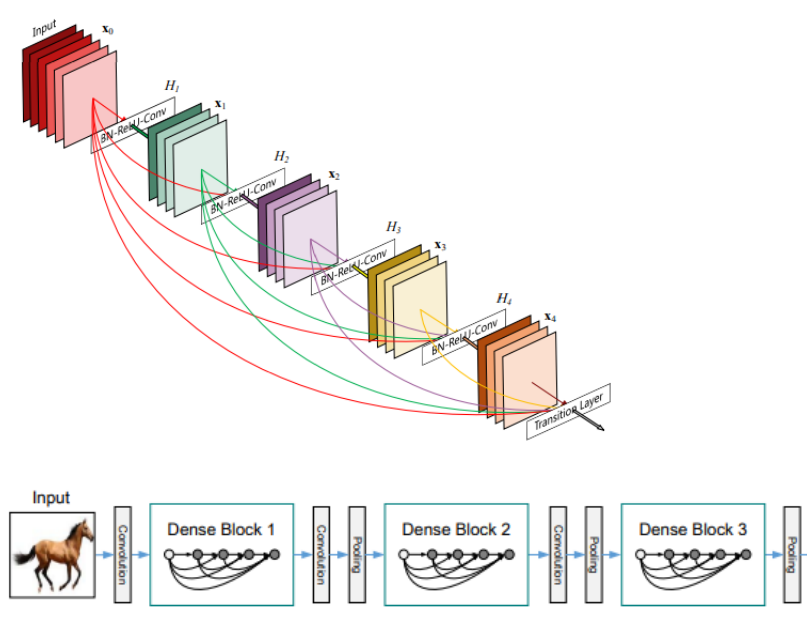
Figure 15. Dense block and layers in DenseNet